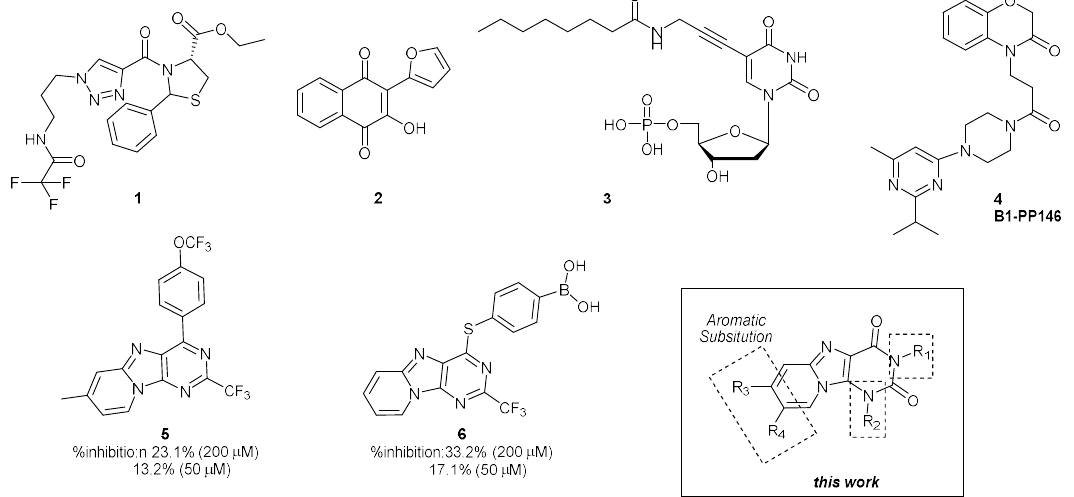
Figure 1. Recent inhibitors of ThyX and targeted pyrido [1,2–3]purine-2,4( 1H,3H )-dione com-